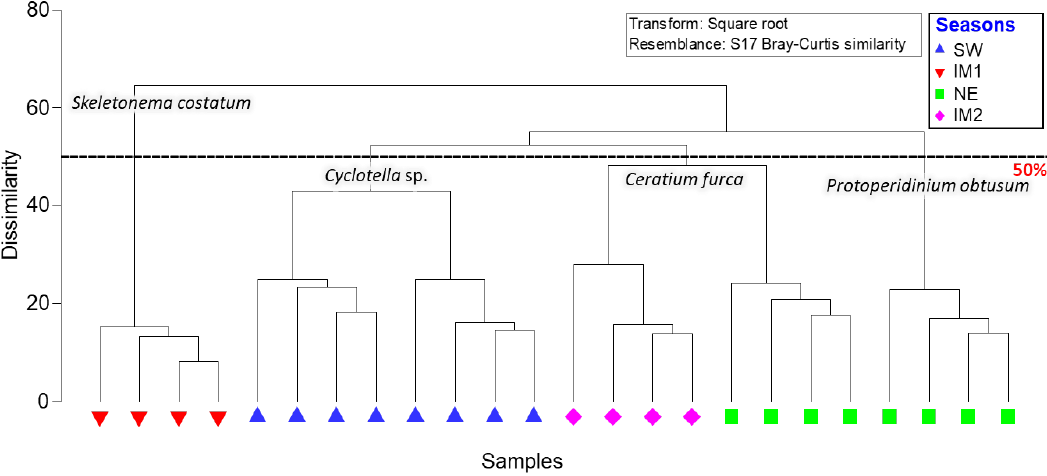
Figure 5. Hierarchical clustering of dendrogram showing dominant species in various clusters associated with seasons (group-average linking 24 phytoplankton samples of Bray Curtis dissimilarities calculated on square-root transformed densities). SW, southwest monsoon; NE, northeast monsoon; IM1, intermonsoon in October; IM2, intermonsoon in April.